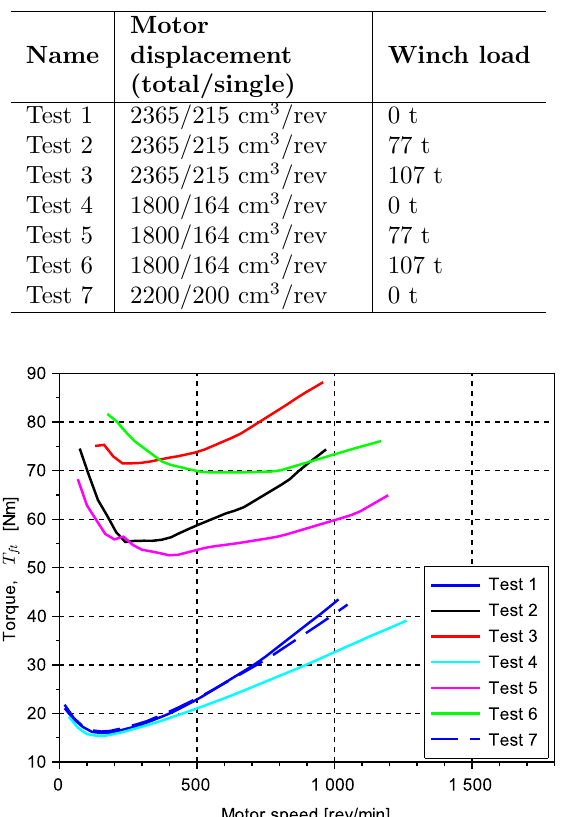
Table 2: Evaluated test scenarios